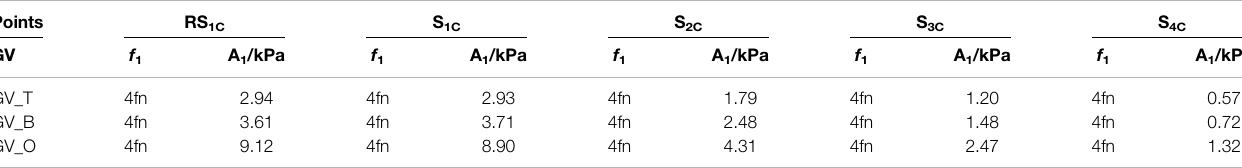
TABLE 6 | Dominant frequency and its corresponding amplitude of points in guide vane.